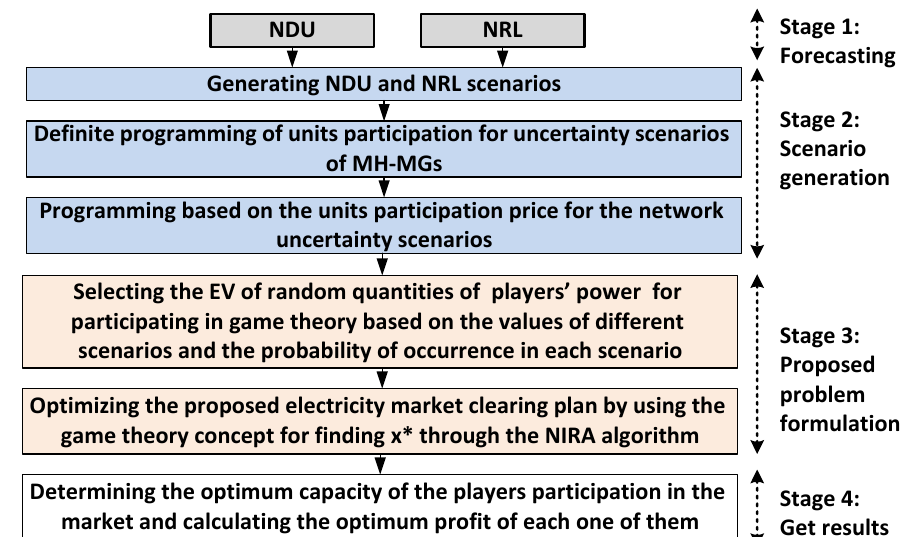
Figure 3. The process of implementing the proposed market structure. Expected value (EV), Nikaido-Isoda/relaxation algorithm